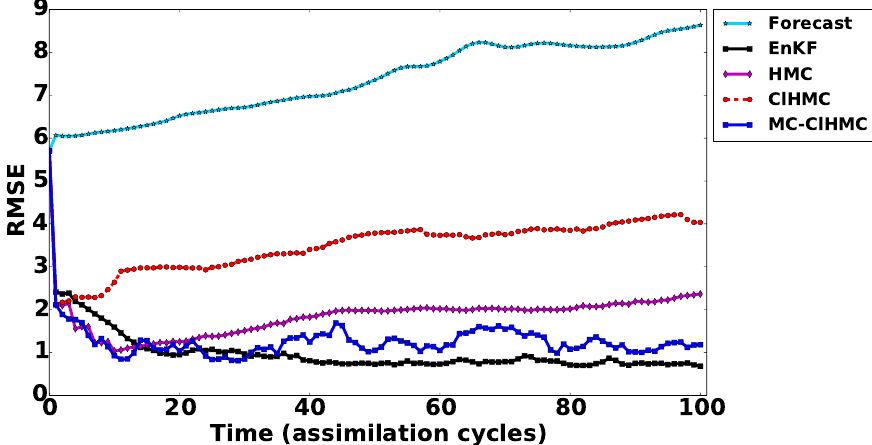
Figure 4. Data assimilation results with the linear observation operator. RMSE of the (31) analyses (cid:96) HMC, and MC- (cid:96) HMC filters. Forecast results here refer to the RMSE obtained by EnKF, HMC, C C obtained from a free run of the dynamical model, with initial condition set to the forecast state at the initial